Question: Express in one sentence what the figure is showing.
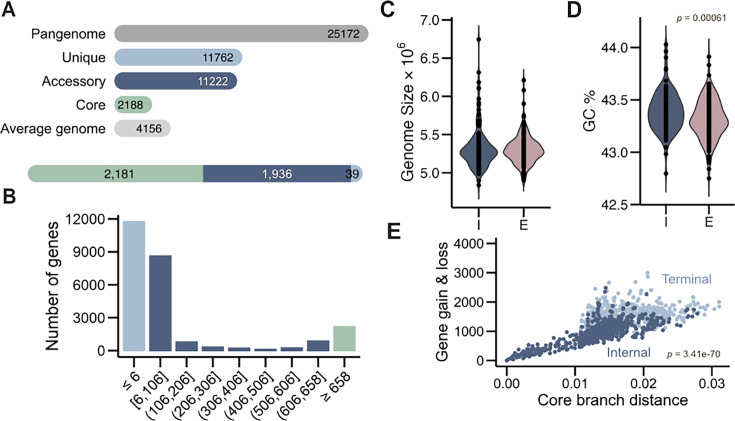
Answer: Pangenome structure of B. fragilis. ( A ) Pangenome size and composition across 664 isolates. Bars indicate total pangenome, genes unique to ≤1% of isolates (unique), genes present in >1% and <99% (accessory), and genes present in ≥99% (core). The lower bar shows the average genome composition per isolate (core, accessory, and rare/unique gene counts). ( B ) Gene frequency spectrum across the pangenome. Histogram shows the number of genes observed in a given fraction of isolates (bin labels reflect counts out of 664). The rightmost bin (green) denotes core genes (≥658/664 isolates). ( C ) Genome size by isolation source, intestinal (I, n = 281) and extra-intestinal (E, n = 280), excluding assemblies derived from metagenomic assemblies, Welch’s t -test, ns. ( D ) GC content by isolation source, intestinal (I, n = 281) and extra-intestinal (E, n = 280), excluding assemblies derived from metagenomic assemblies, Welch’s t -test, P = 0.00061. ( E ) A measure of core compared with accessory genome evolution through cumulative gene gain/loss events (accessory genome) vs cumulative phylogenetic branch distance (core genome) (Student’s t -test, P = 3.41e −70 ), colored by terminal (light blue) and internal branches (dark blue) using the Panstripe algorithm ( 35 ).